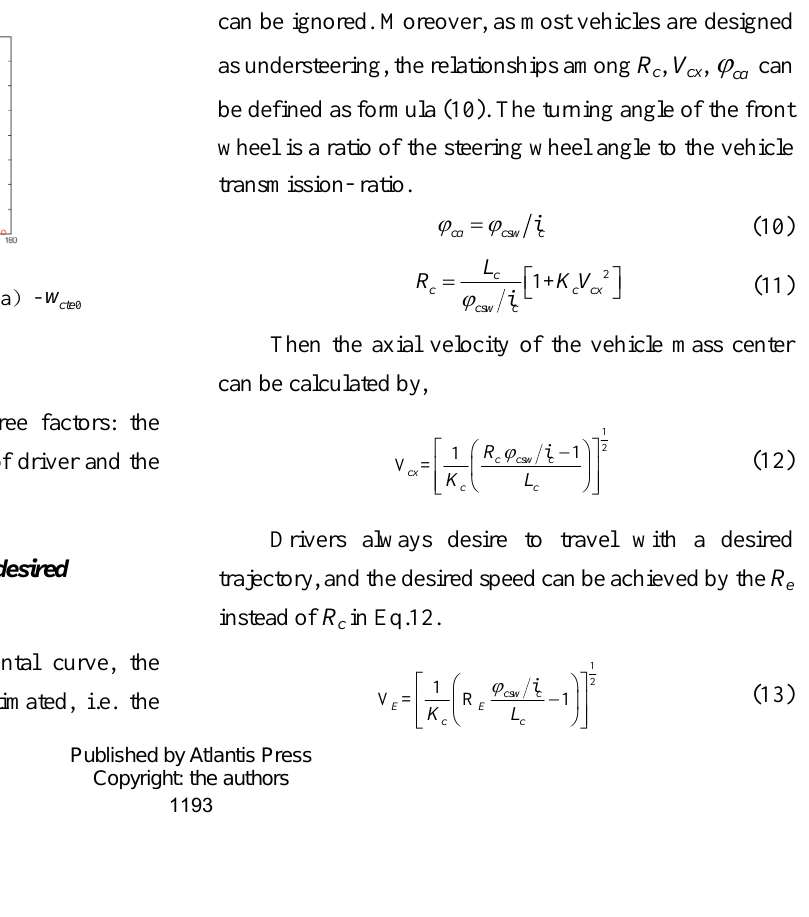
Fig.12 Analysis of desired trajectory models w indicates the forward The longitudinal offset 0 cte trendency of the starting point of desired trajectory. Its models show that the longitudinal offset from the curve only related to the road curve, for example the desired trajectory (a), and steering angle is 40 ° ~180 ° , w with the steering regularity of the longitudinal offset 0 cte angle is shown Fig.13.